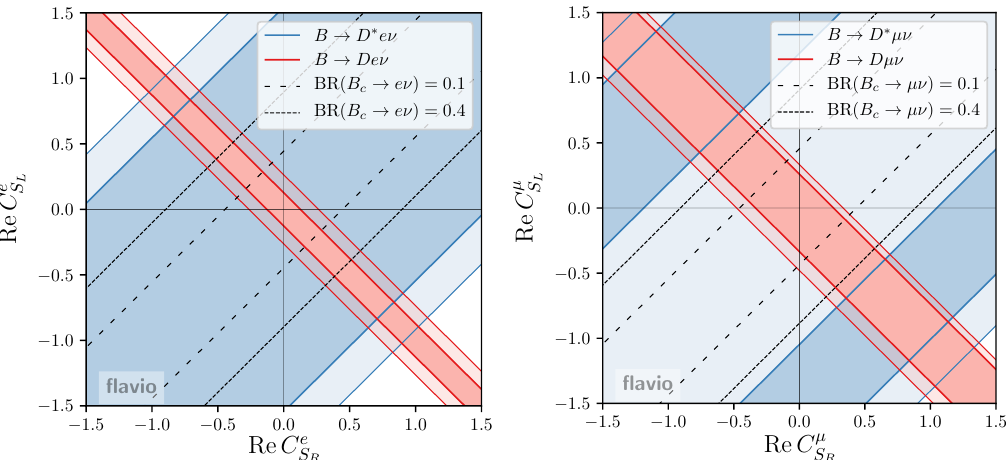
Figure 6 . Constraints on the scalar Wilson coe(cid:14)cients from exclusive decays and the total width of the B c meson, seperately for electrons (left) and muons